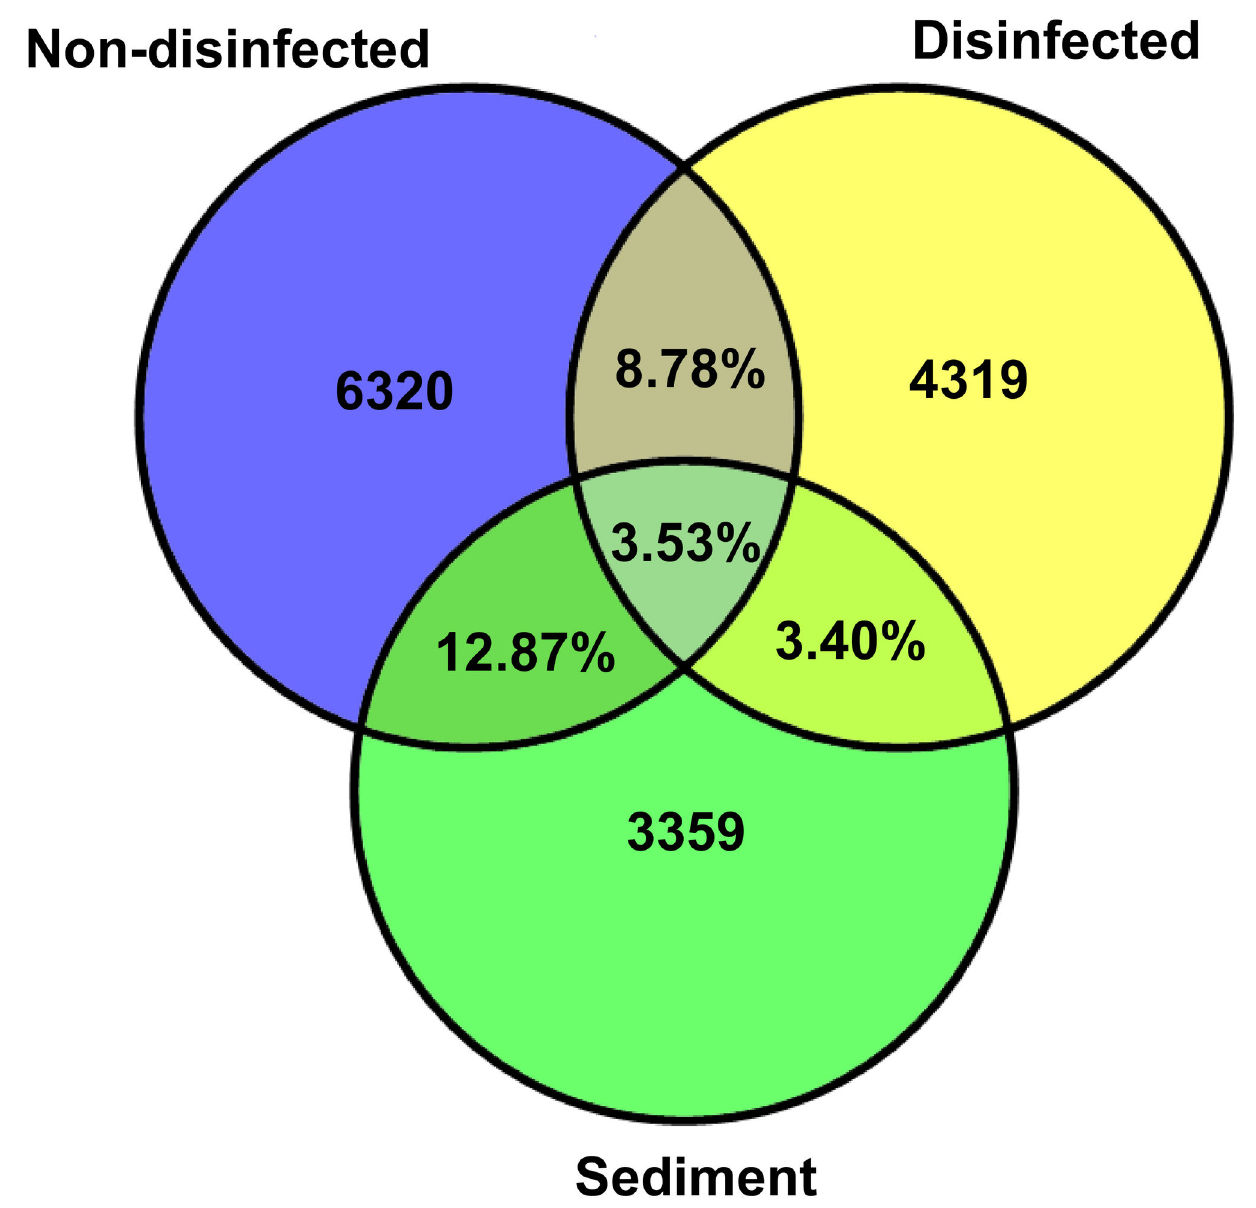
Figure 2. Venn diagram representing bacterial communities shared within the three different treatments. Numbers on each treatment represent the number of OTUs and percentages on overlapping areas represent the percentage of shared OTUs.